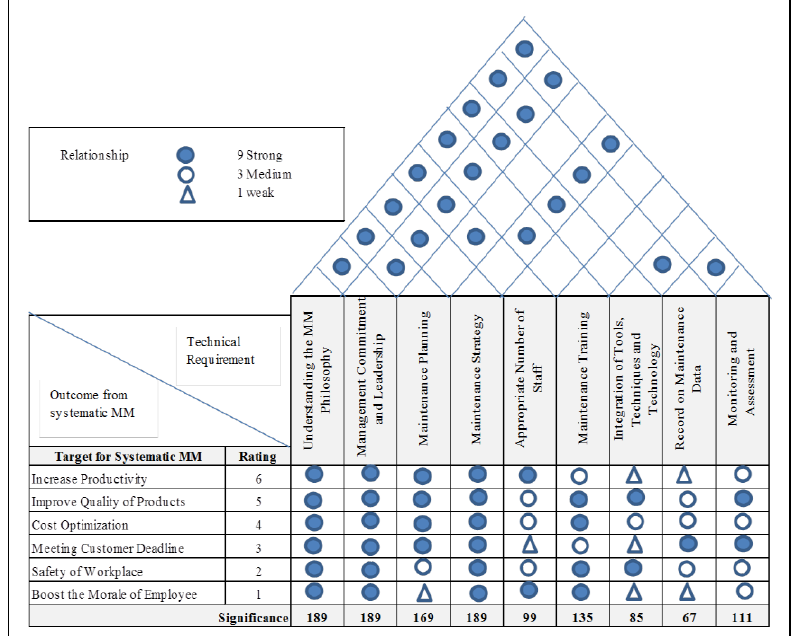
Figure 3. MM Framework II as Proposed by the researcher, adapted from [57,